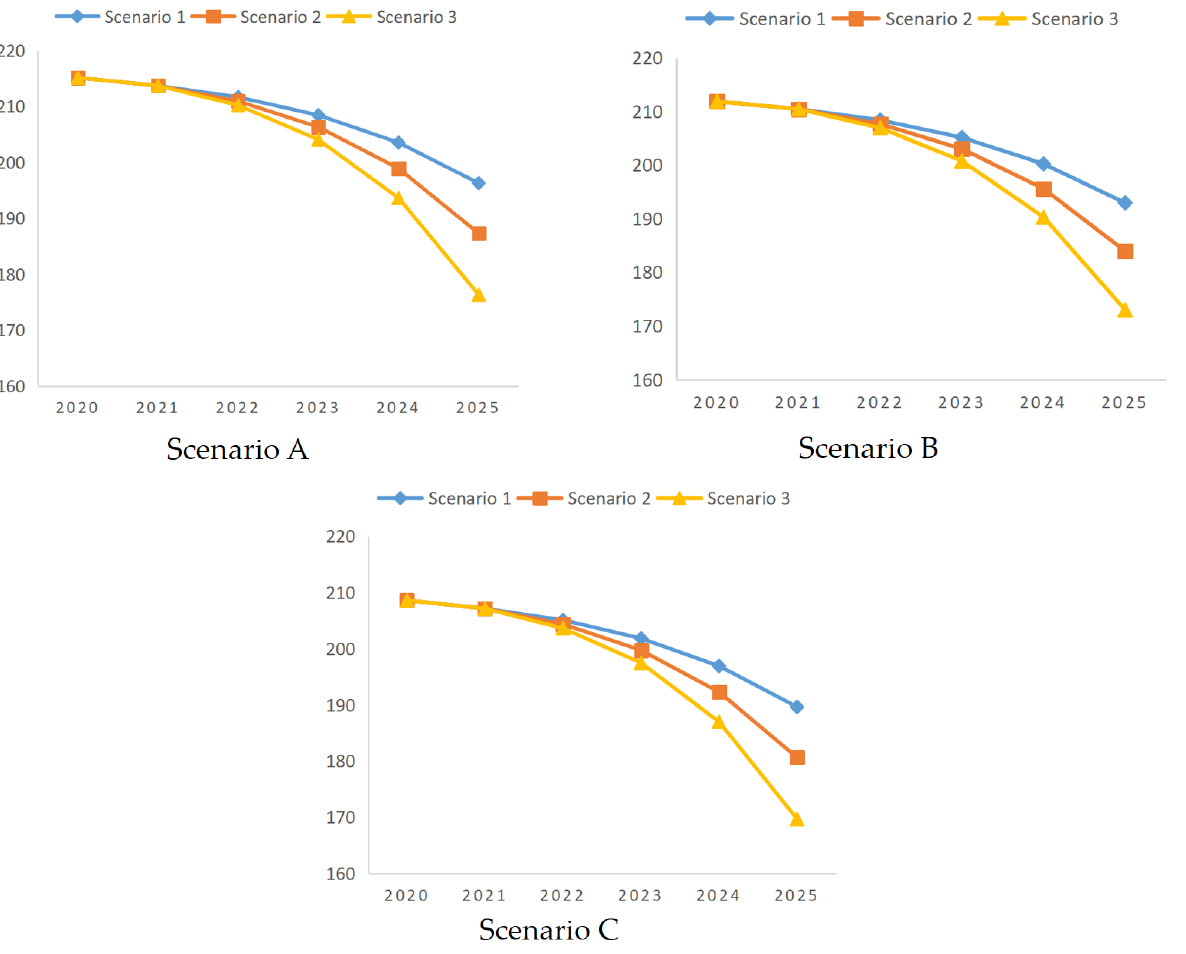
Figure 11. Total net emission reduction of bicycle-sharing.